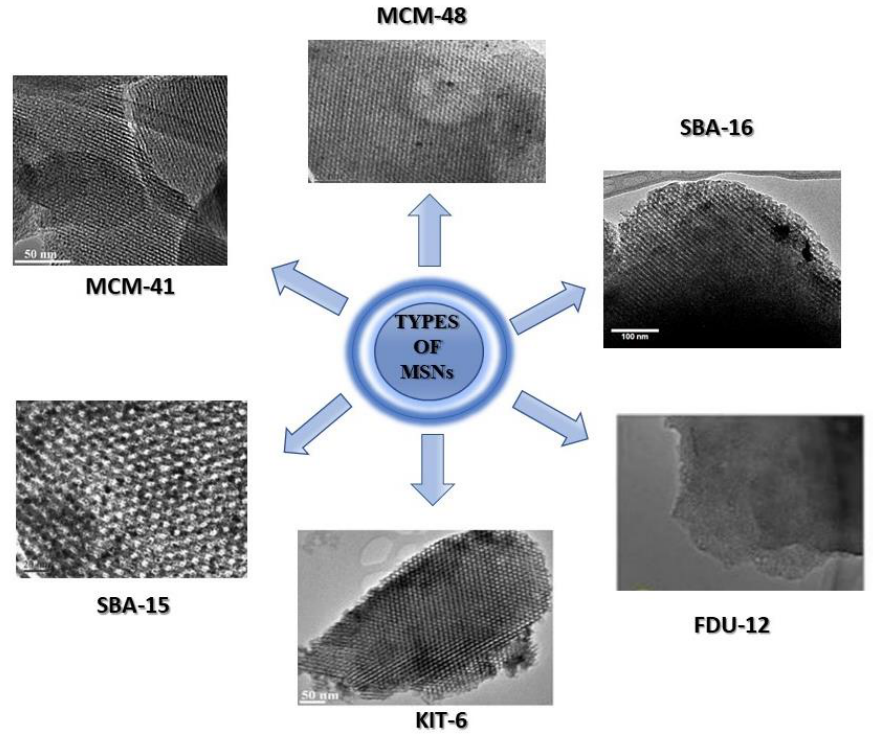
Figure 2. Types of mesoporous silica nanoparticles. Adapted from [17], published by MDPI, 2010, [18], published by MDPI, 2022, [19], published by MDPI, 2013, [20], published by MDPI,